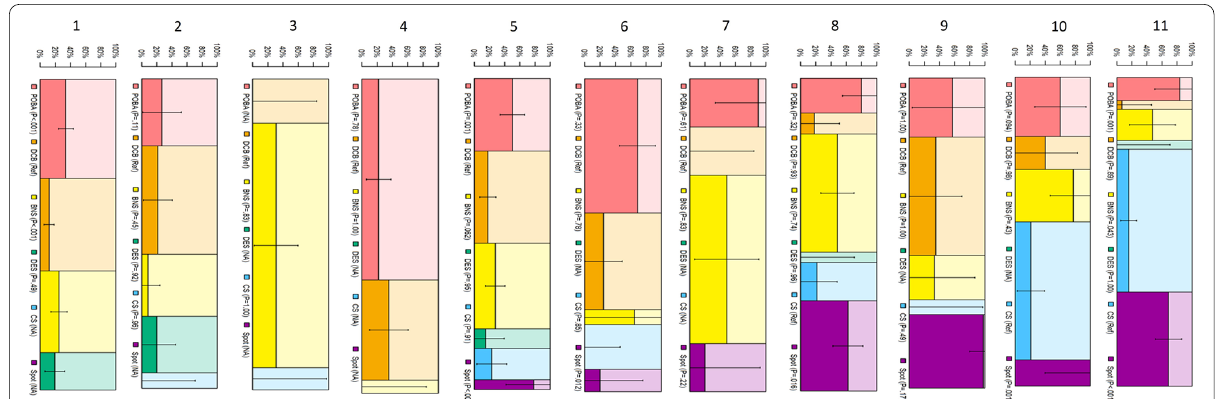
Fig. 5 The restenosis rate applied to the 11 categories. BNS: bare nitinol stent, CS: covered stent, DCB: drug-coated balloon, DES: drug-eluting stent, POBA: plain old balloon